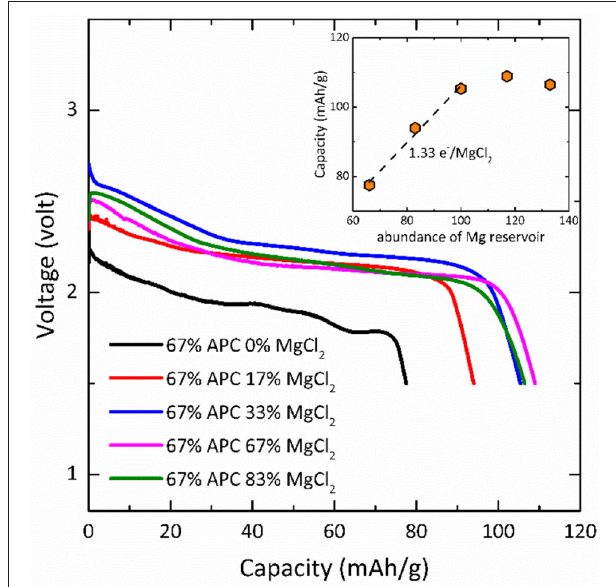
FIGURE 6 | Discharge of Mg-NaCrO 2 hybrid cell using solid MgCl 2 as additional Mg reservoir. The percentage shows the ratio of cathode that can be fully reacted with the supply of Mg 2 + in the electrolyte and in the MgCl 2 . Insert: discharge capacity as a function of Mg 2 +